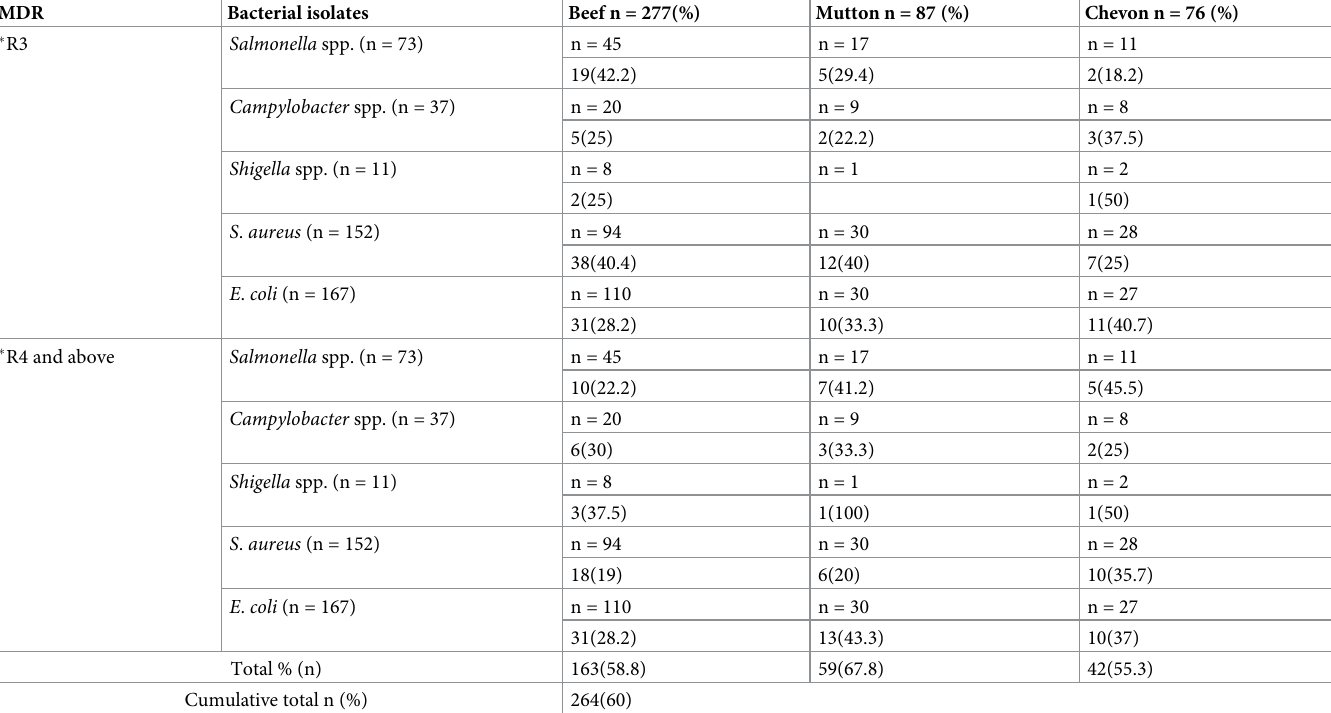
Table 5. MDR profiles of bacterial isolates from RTE raw minced meats served in hotels and restaurants of Arba Minch town from 01 July to 31 December, 2020. MDR Bacterial